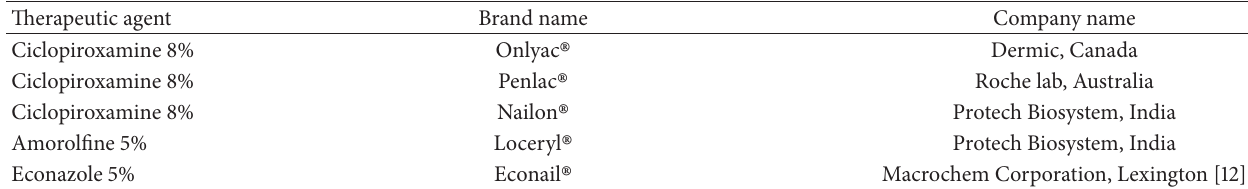
Table 1: A compilation of commercially available nail lacquers.